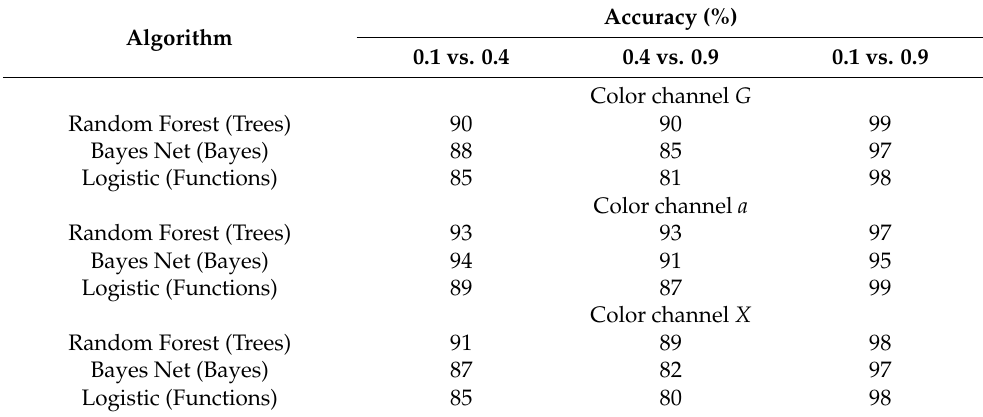
Table 4. The accuracy of distinguishing the ripening stages of peach ‘Redhaven’ based on sets of textures selected from flesh images in different color